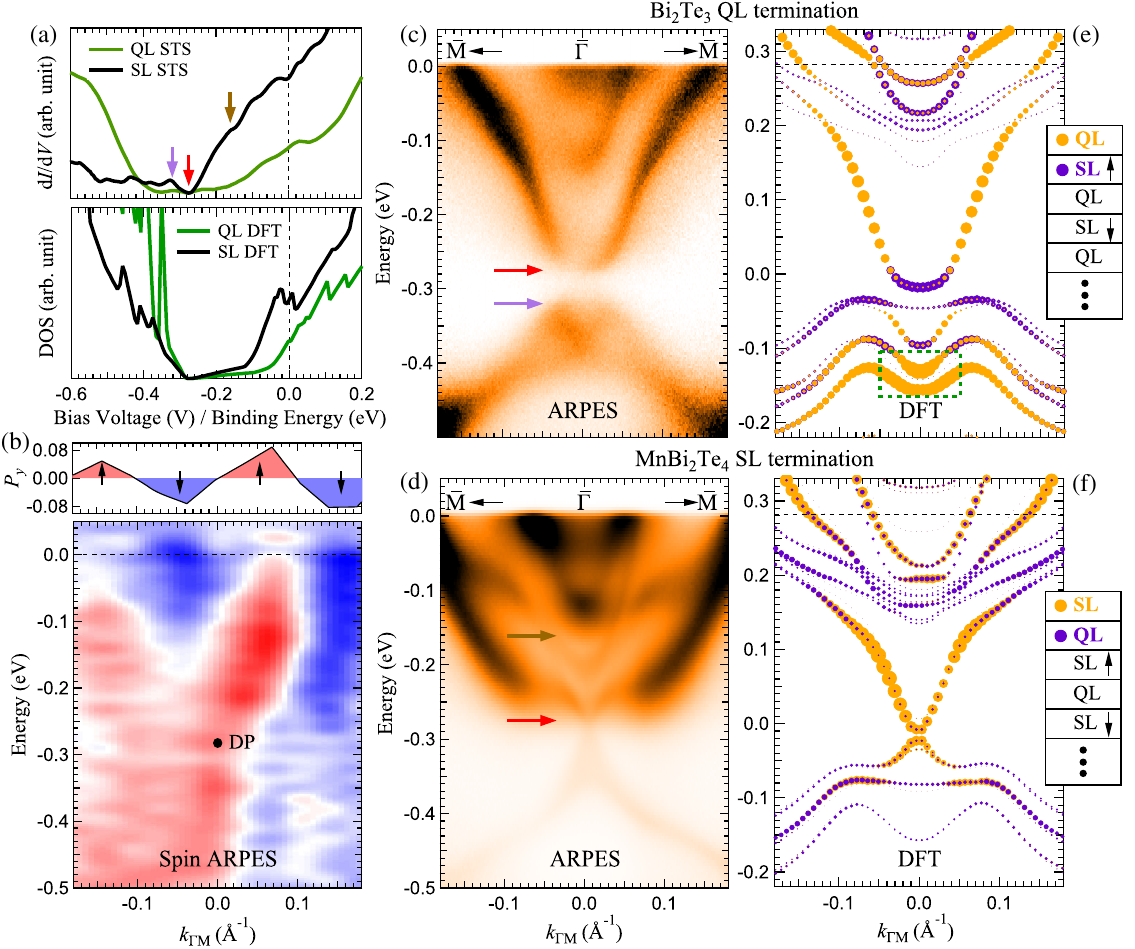
FIG. 2. Electronic structure of the two terminations of MnBi 4 Te 7 . (a) Top: Averaged dI=dV spectra of a series of STS spectra obtained at defect-free areas of the QL (green) and SL (black) terminations. Tunneling parameters: V mark the hybridization gap opening on the QL termination (red and purple), the Dirac point (red), and the onset of the inner Rashba-like splitting band on the SL termination (brown), in good agreement with the ARPES measurement. Bottom: DFT-calculated surface- dependent DOS for both terminations. The surface projections include the top two surface layers, containing one SL and one QL. The calculated DOS plots are offset to − 285 meV to match the Dirac point of SL termination. The dashed line marks the Fermi level. (b) Spin-polarized ARPES map for both terminations of MnBi 4 Te 7 , with a line cut at E B ¼ 0 . 08 eV showing the antiparallel helicity of the two bands. (c) and (d) are the ARPES intensity maps of the QL and SL terminations at the highlight important STS features in (a). (e) and (f) show the results from density functional theory calculations for the QL and SL terminations, respectively. The slab model assumes a nonmagnetic SL termination for (f), while for (e) an A -type AFM spin configuration is used with the assumption that the magnetic order of the second SL is protected by the topmost QL. The green dashed box in (e) marks the gapped Dirac cone of the surface